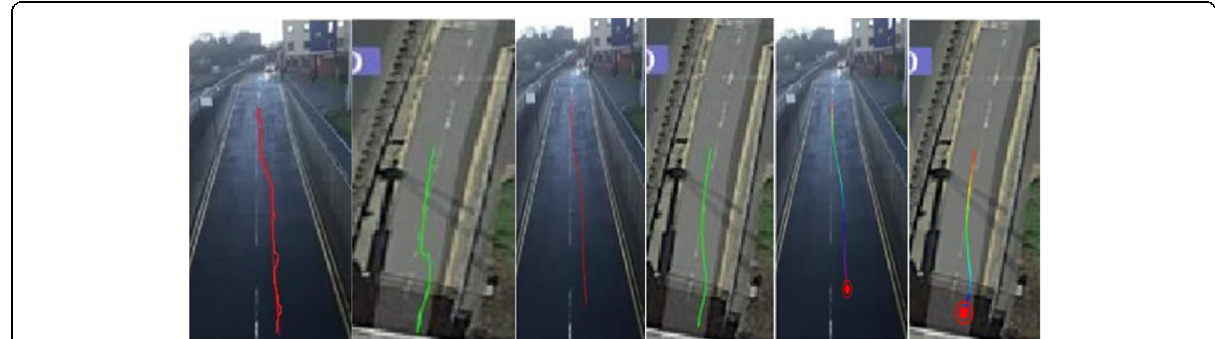
Fig. 19 a Chaotic vehicle trajectory. b Smoothed curve for glyph-based visualization. c Time-stamped semantic glyph representation and lane changes